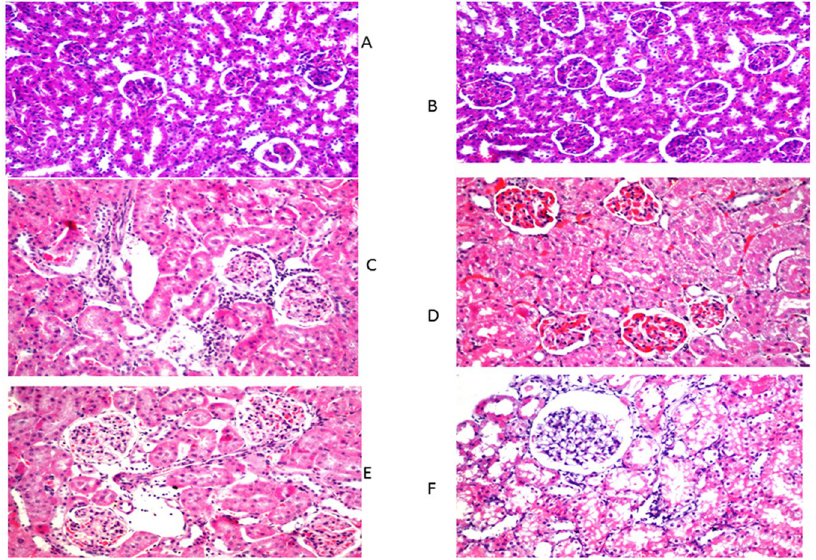
Figure 2. Histopathalogical studies of kidney. ( A ) Control; ( B ) Naive; ( C ) Diabetes mellitus group; ( D ) Diabetic nephropathy group; ( E ) caffeic acid prophylactic group; ( F ) caffeic acid treated group. H&E X 400.